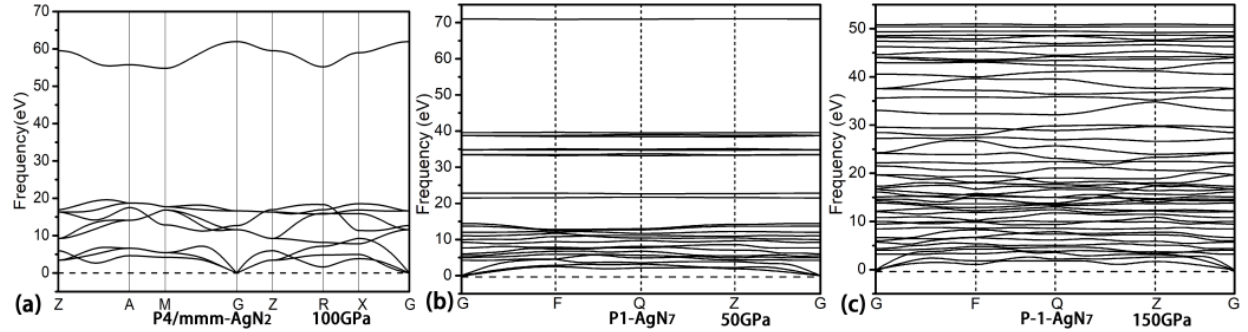
Figure 2. The phonon dispersion of P4/mmm-AgN 2 at 100 GPa ( a ), the P1-AgN 7 at 50 GPa ( b ) and P-1-AgN 7 at 150 GPa ( c ).